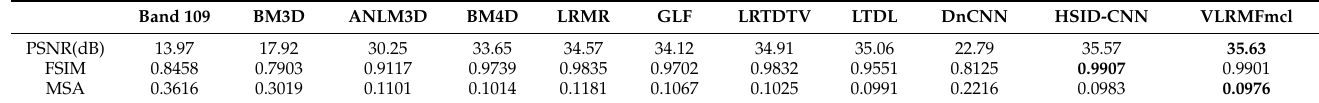
Table 1. Quantitative evaluation results for the Pavia Centre data set.